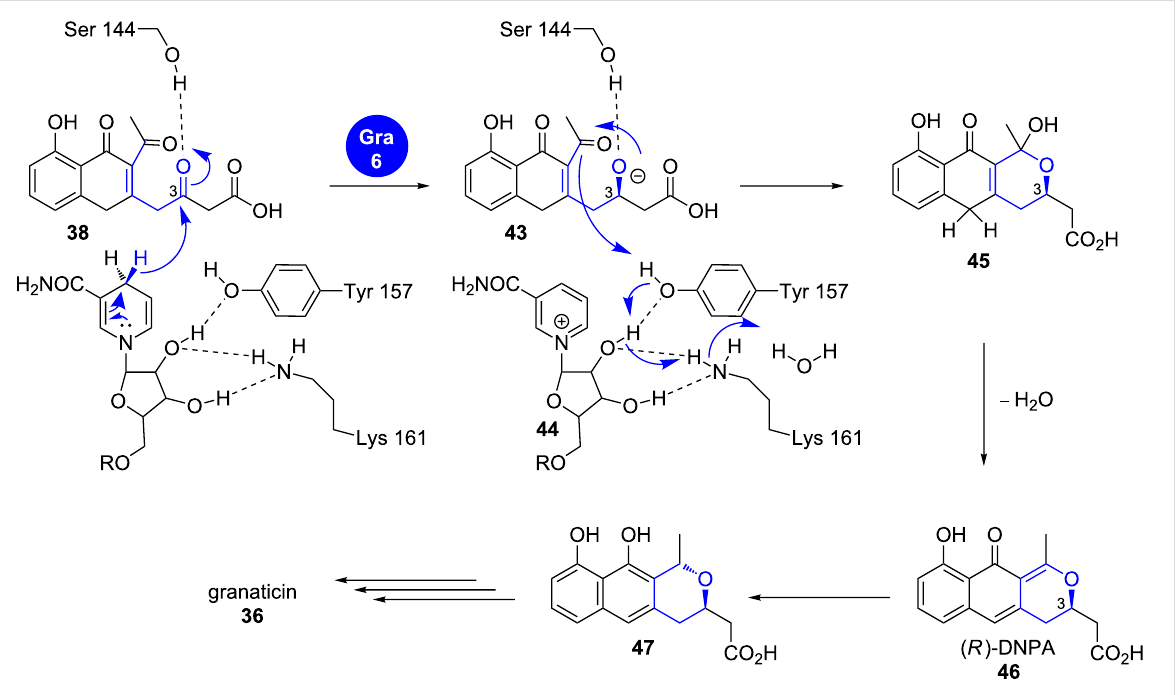
Scheme 7: Pyran formation in granaticin ( 36 ) biosynthesis. DNPA: 4-dihydro-9-hydroxy-1-methyl-10-oxo-3 H -naphto[2,3- c ]pyran-3-acetic acid. Modi- fied from